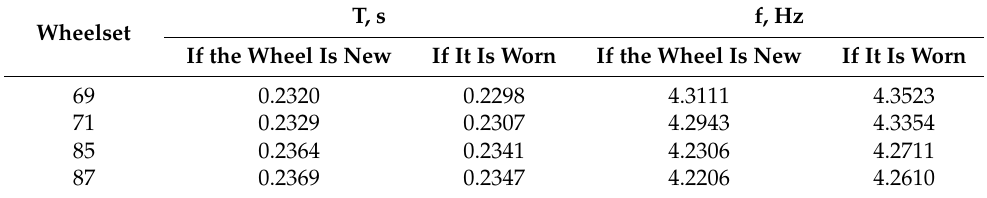
Table 3. Periods (T) and frequencies (f) of the damage repetition of the new and worn wheel.